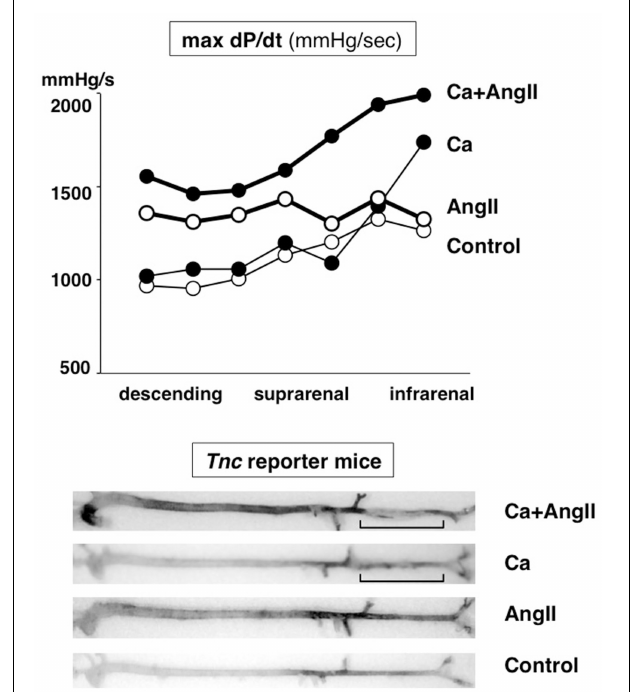
FIGURE 3 | Mouse model of aortic stress. Mouse model of aortic stress was created by inducing hypertension with angiotensin II infusion and aortic stiffness with periaortic application of CaCl 2 in the infrarenal aorta (brackets). Top panel: Hemodynamic stress on aortic wall was evaluated by measuring dP/dt (mmHg/s) with aortic catheterization. Thick lines indicate AngII-treated groups. Closed circles indicate Ca-treated groups. Bottom panel: Stress response of aortic wall was evaluated by X-gal staining of the aorta from Tnc reporter mouse, in which blue staining indicates Tnc gene activity. Adapted from Kimura et al.